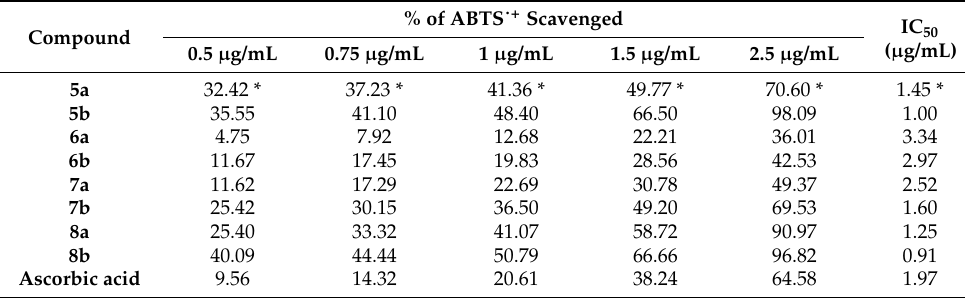
Table 1. Results of the ABTS˙ + scavenging assay.